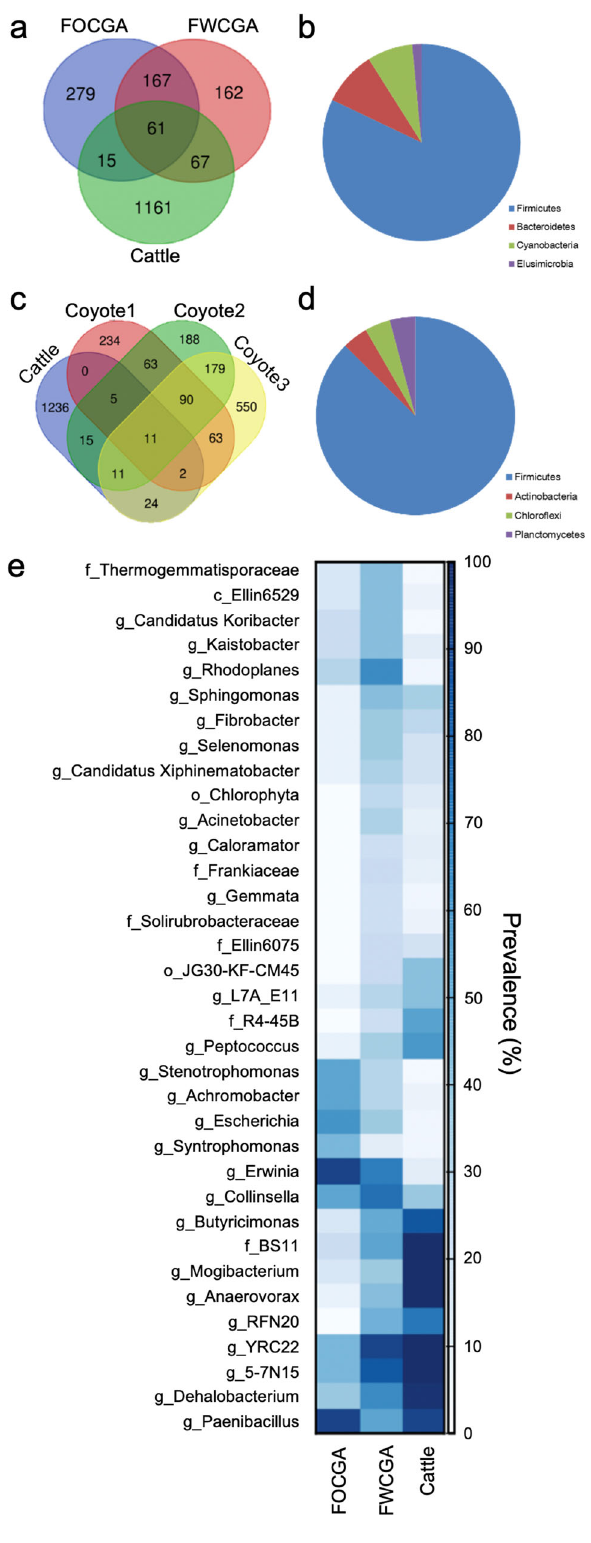
of FWCGA on cattle microbiome communities, cattle had only a minimal effect on feral swine. Only 2% and 0.003% of microbiota communities of FWCGA (Fig. 5e and Supplementary Fig. 4, and Supplementary Data 1) and FOCGA (Fig. 5f and Supplementary Fig. 5, and Supplementary Data 1) were predicted to be originated from cattle, respectively. These data indicate that cohabitation enhances transmission of microorganisms between animals.